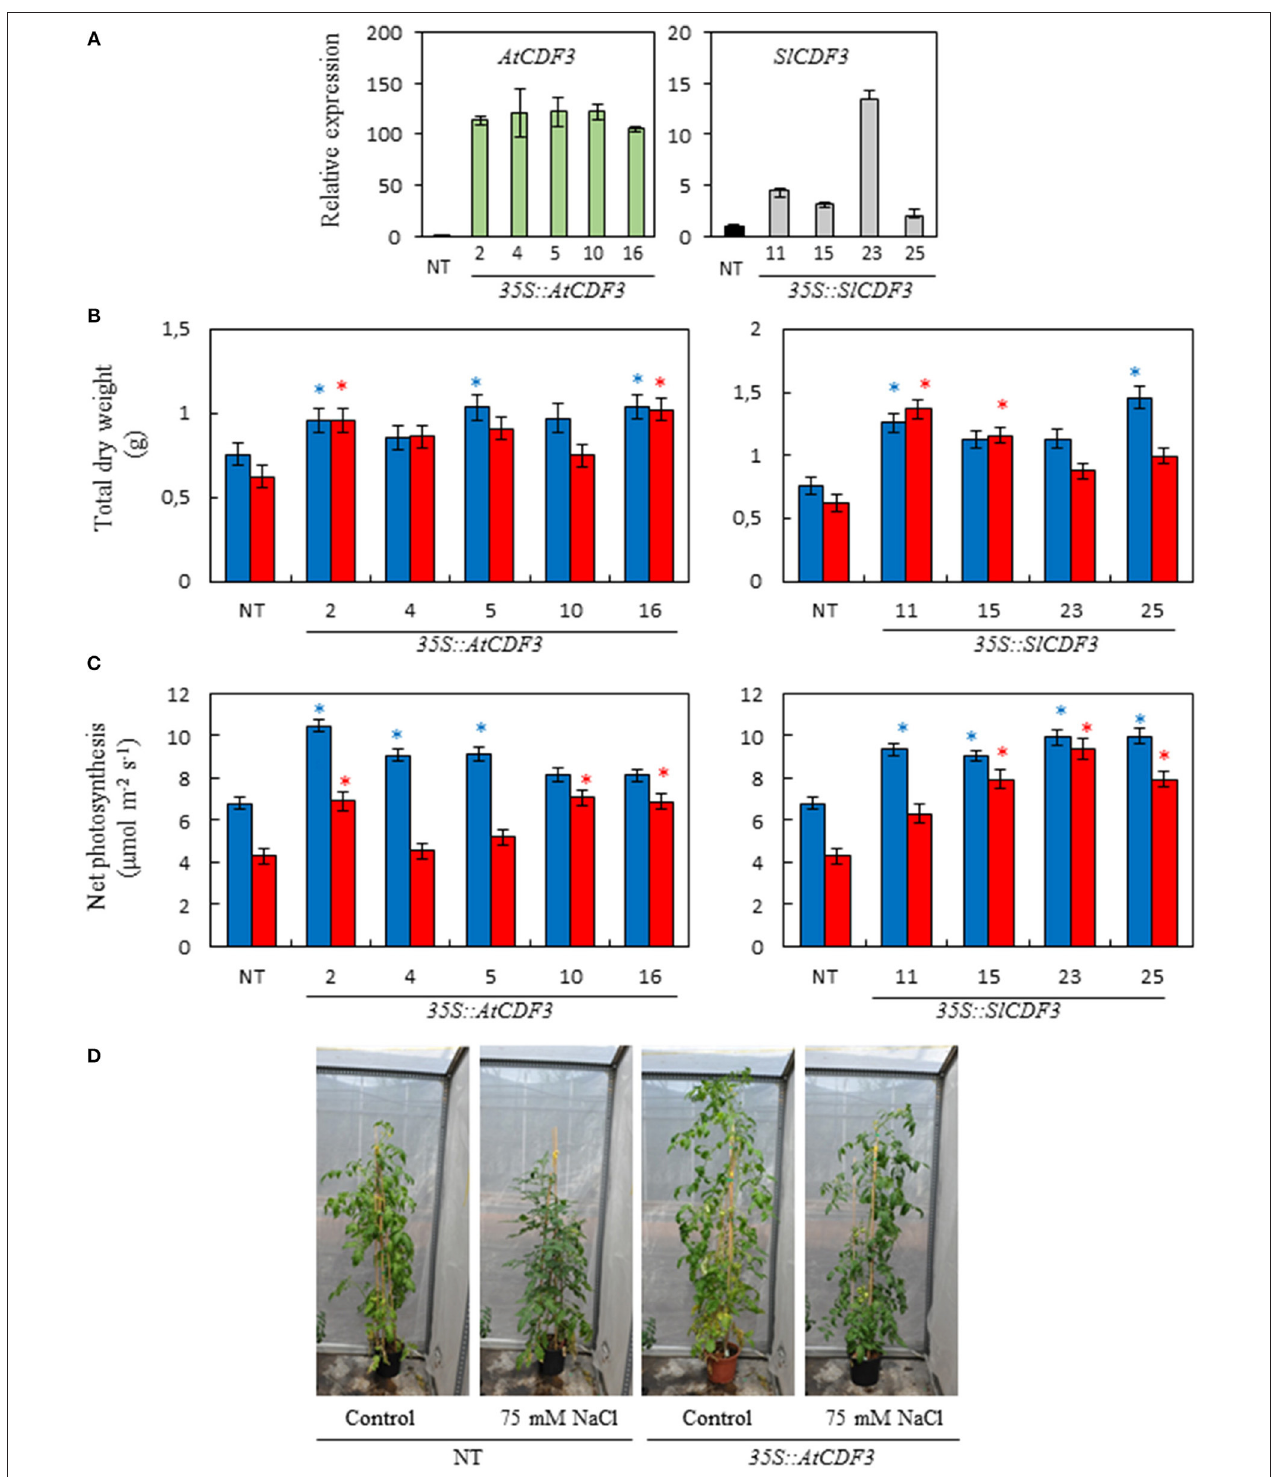
FIGURE 1 | Phenotypic characterization of the 35S::AtCDF3 and 35S::SlCDF3 tomato lines. (A) Expression levels of the corresponding gene AtCDF3 or SlICDF3 analyzed by RT-qPCR. (B) Biomass and (C) photosynthetic rate of the 35S::AtCDF3 , 35S::SlCDF3 and NT tomato lines grown under the control (blue bars) and 75 mM NaCl (red bars) conditions. Thirty-day-old plants grown in hydroponic culture were subjected to moderate salinity (75 mM NaCl). Photosynthesis and growth determinations were performed after 15 days of treatment. (D) Representative examples of the NT and 35S::AtCDF3 (line 2.3) plants grown under the control or salt stress conditions in the greenhouse. Asterisks indicate significant differences ( P < 0.05) of the transgenic plants with the non-transformed plants (NT) under the same growth condition. NT, non-transformed.